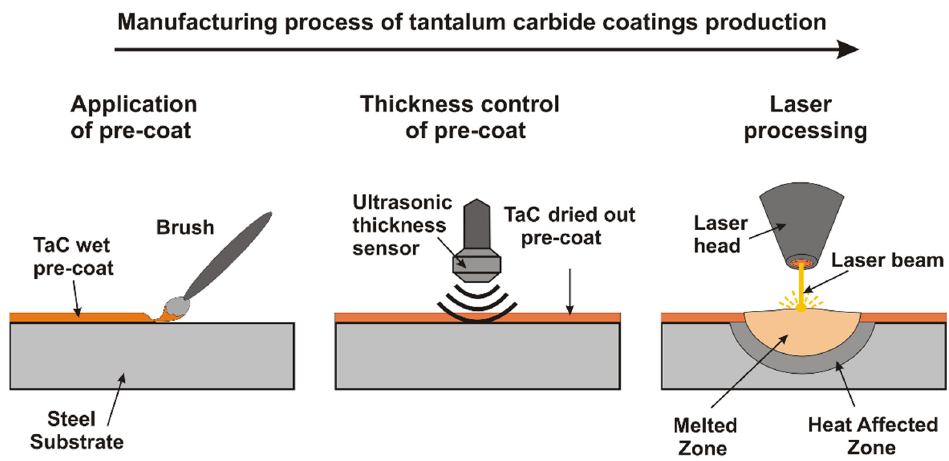
Figure 2. Manufacturing process of TaC coatings.